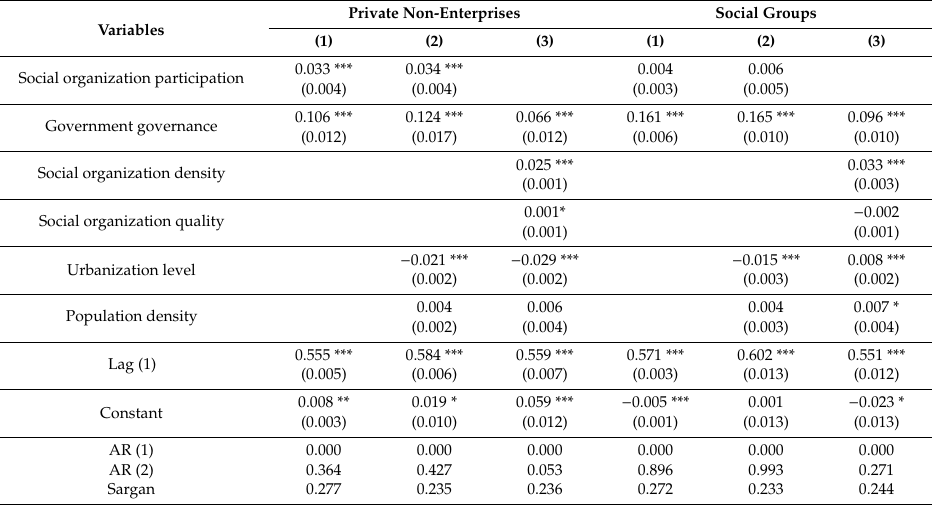
Table 11. Robustness test by social organization